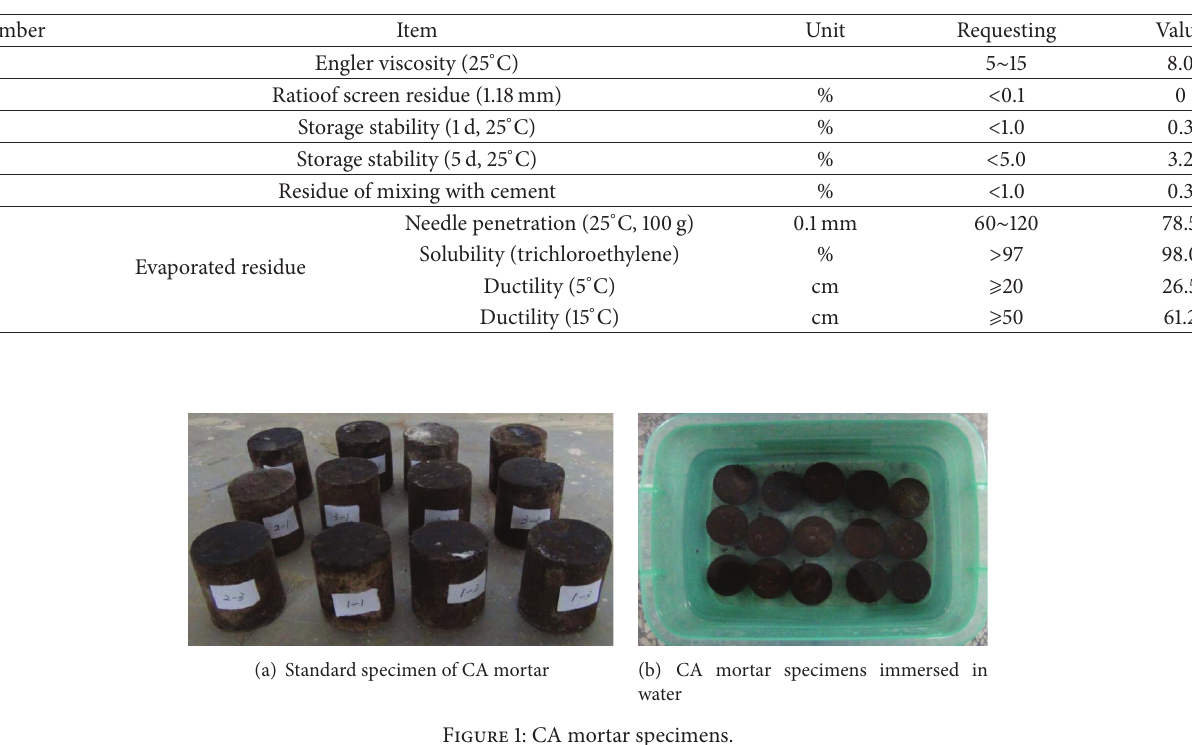
Table 1: Properties of emulsified asphalts.